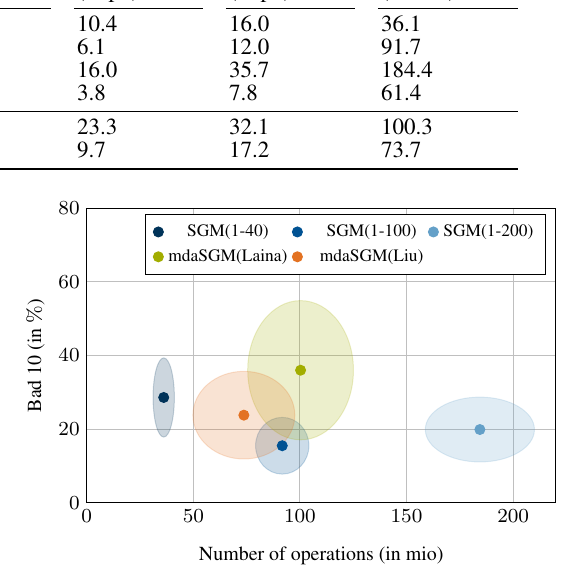
Figure 11. Relation between performance and computational complexity of mdaSGM and baseline SGMs for the Middlebury 2014 Stereo benchmark. Mean and standard deviation are represented by dots and ellipses